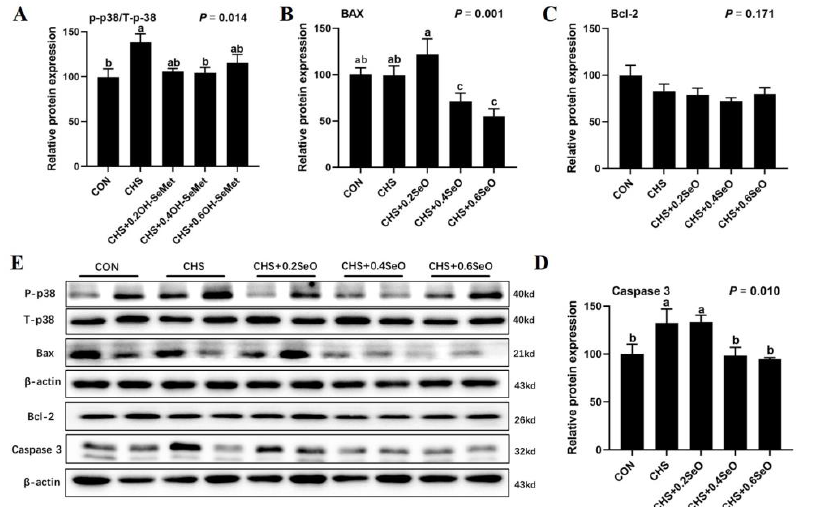
Figure 4. Effects of CHS and SeO supplementation on the abundance of protein related to apoptosis in the spleen. ( A – D ) Relative protein expression level, ( E ) Relevant protein bands. The results were expressed as mean ± SEM ( n = 6). Different letters (a, b and c) denote significant differences ( p <